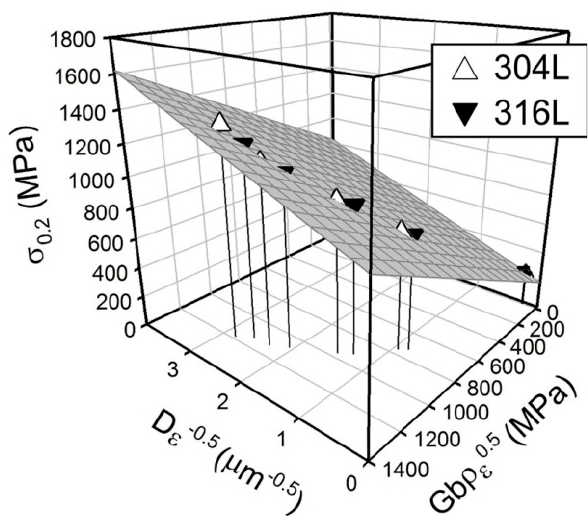
Figure 15. Relationship between the yield strength ( σ 0.2 ), the grain size (D ε ) and dislocation density ( ρ ε ) strengthening in 304L and 316L stainless steels subjected to rolling at 473 K.